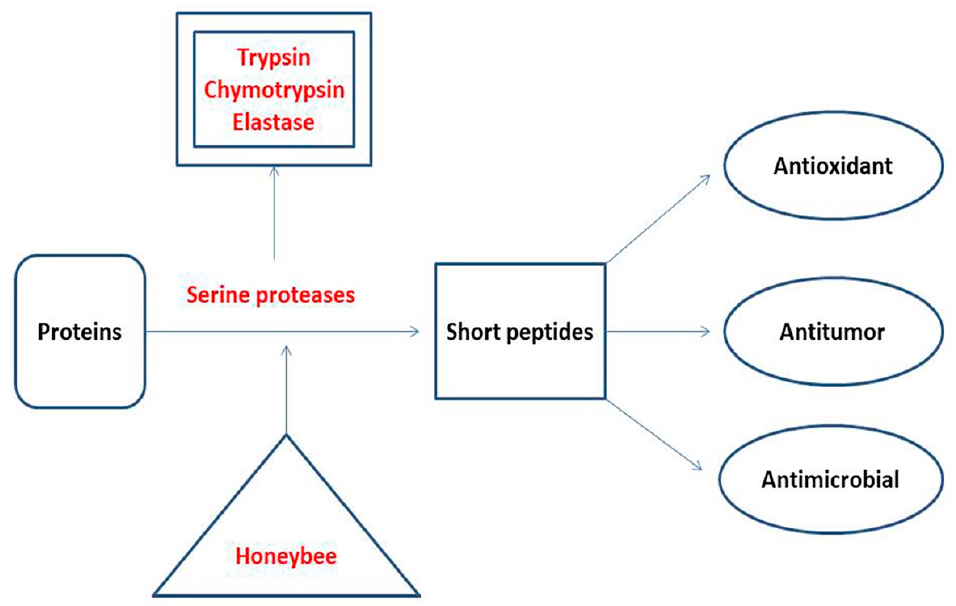
Figure 2. The proteases in honey: their types, origin, substrate, products, and their contribution to the biological activities of honey [6,30,37,69–73].